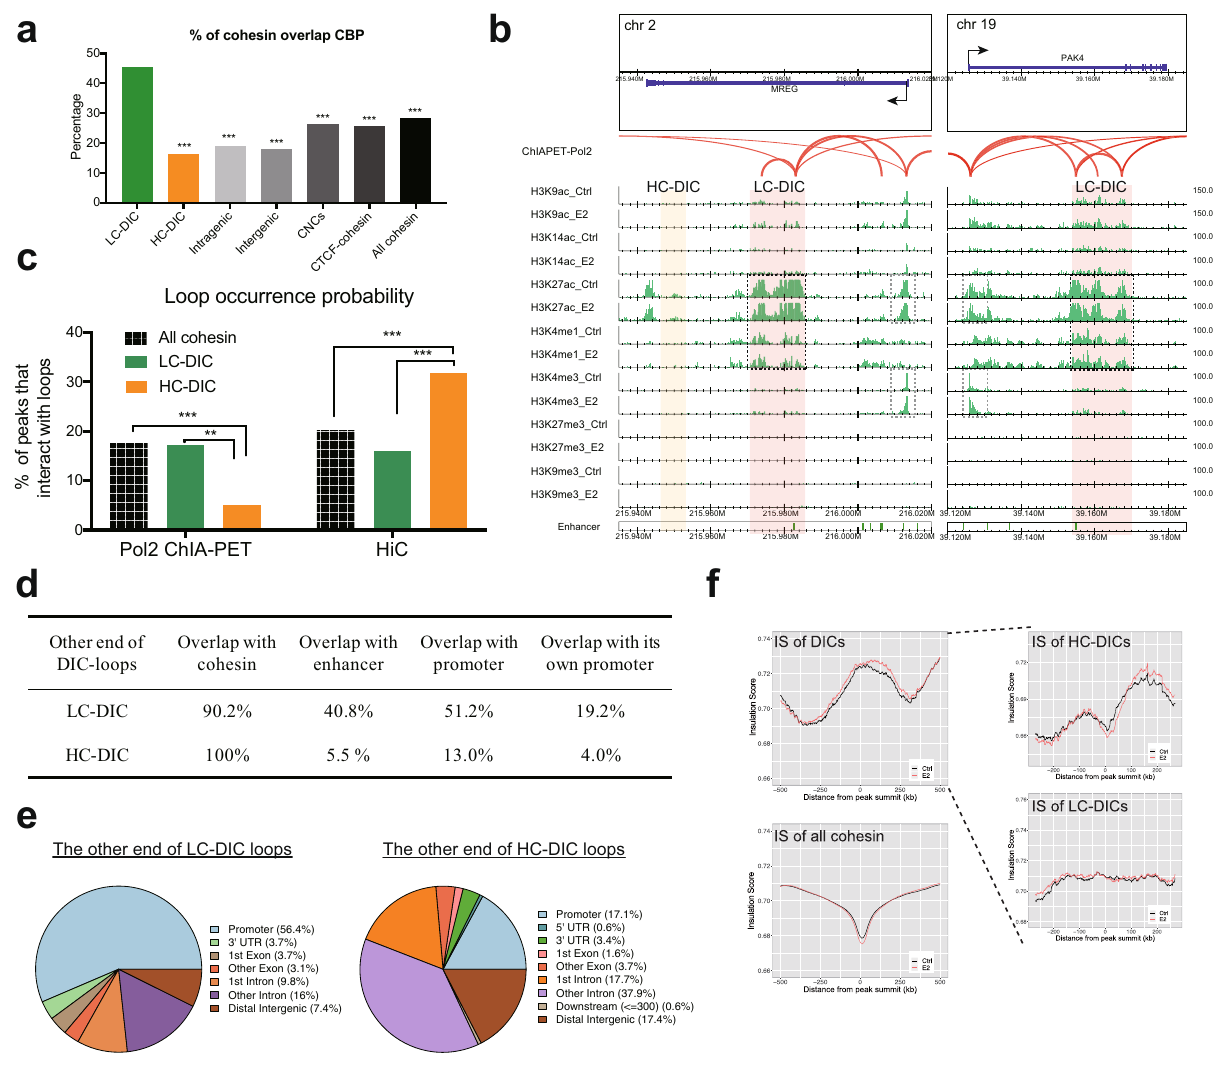
Fig. 2 Enhancers and loops on DICs. a The proportion of cohesin overlap with CBP peaks. Fisher ’ s exact test (two-sided) was used between LC-DICs and other cohesin sites. ** p < 10 − 5 , *** p < 10 − 10 . The exact p-values from left to right are 1.5 × 10 − 10 , 1.1 × 10 − 31 , 1.4 × 10 − 37 , 9.9 × 10 − 17 , 2.0 × 10 − 15 , 9.8 × 10 − 14 . Source data are provided in the Source Data fi le. b Genomic binding of multiple histone markers. Enhancer markers H3K27ac and H3K4me1 (black dashed box) were enriched at LC-DICs. Gray dashed boxes indicate histone markers for promoters. Red arcs show Pol2-mediated loops. c Loop occurrence probabilities on DICs, calculated based on Pol2 ChIA-PET or Hi-C data. We used Fisher ’ s exact test (two-sided) to do statistical comparisons. * p < 0.05, ** p < 0.01, *** p < 0.001. For ChIA-PET: all cohesin vs. HC-DIC p = 5.0 × 10 − 5 , LC-DIC vs. HC-DIC p = 0.0013; For Hi-C: all cohesin vs. HC-DIC p = 0.0003, LC-DIC vs. HC-DIC p = 9.0 × 10 − 5 . Source data are provided in the Source Data fi le. d The percentage of HiC loops (LC-DICs and HC-DICs) that interacted with cohesin, enhancers, promoters or the promoter of their host gene. e Genomic distribution of the other end of DIC-loops as generated by ChIPseeker. Source data are provided in the Source Data fi le. f Insulation scores (IS) for each 25-kb genomic region around DICs or all cohesin sites (summit ± 500 kb). DICs were further divided (dashed line) into HC-DICs and LC-DICs. Source data are provided in the Source Data fi